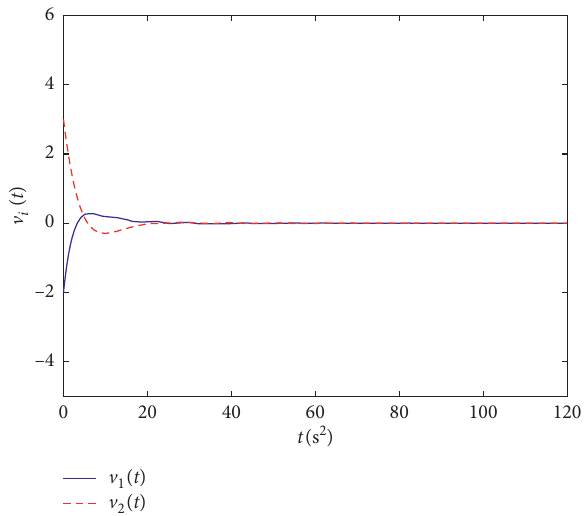
Figure 3: The velocity trajectory of each agent when τ �